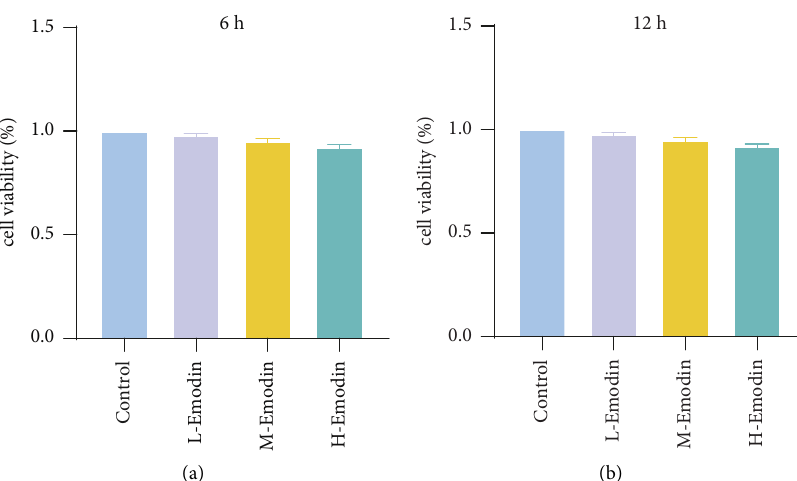
Figure 2: Emodin efects on RAW264.7cell viability ( n � 3). (a) Cell viability after 6h of emodin treatment; (b) cell viability after 12h treatment with